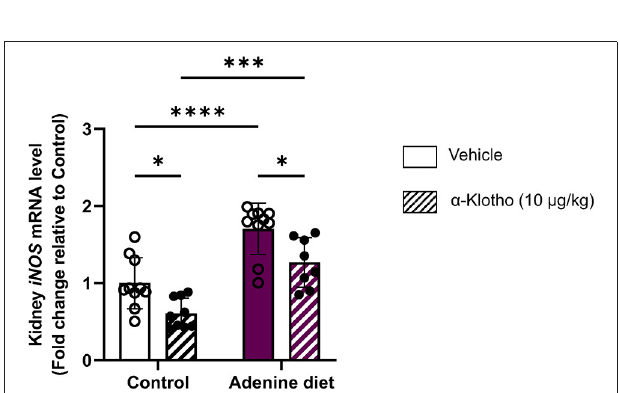
FIGURE 8 | Response of renal iNOS mRNA expression in CKD and klotho administration. C57BL/6J male mice were fed control diet or 0.2% adenine diet. After 8 weeks, mice in each group were further divided into 2 groups and were injected with either saline or mouse recombinant Klotho protein (10 µ g/kg) 24h prior to sacrifice. Quantitative real-time RT-PCR for renal inducible nitric oxide synthase ( iNOS ). Data are expressed as fold change (2 11 Ct ) relative to housekeeping gene Hprt . Samples were measured in duplicates. Data are represented as mean ± SD ( n = 8–9 per group). * P < 0.05, *** P < 0.001, **** P < 0.0001 compared to